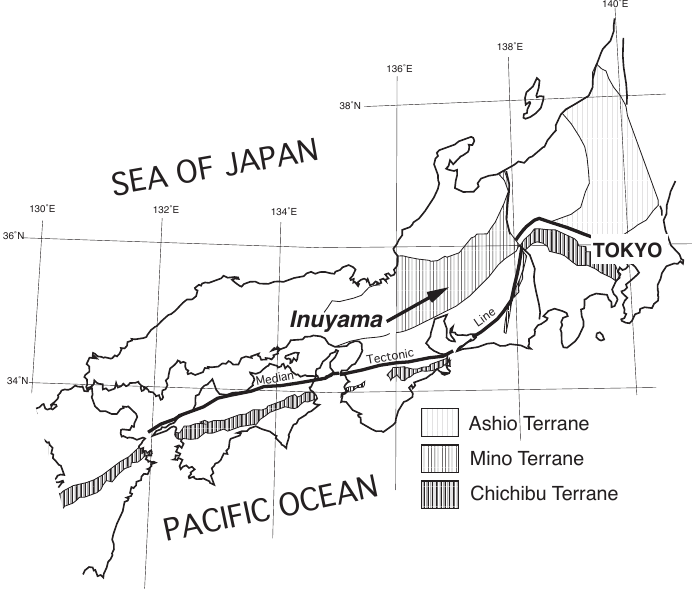
Fig. 2. Geographic map of Japan showing the three accretionary complexes presently exposed – Ashio Terrane, Mino Terrane and Chichibu Terrane – and the position of the Inuyama